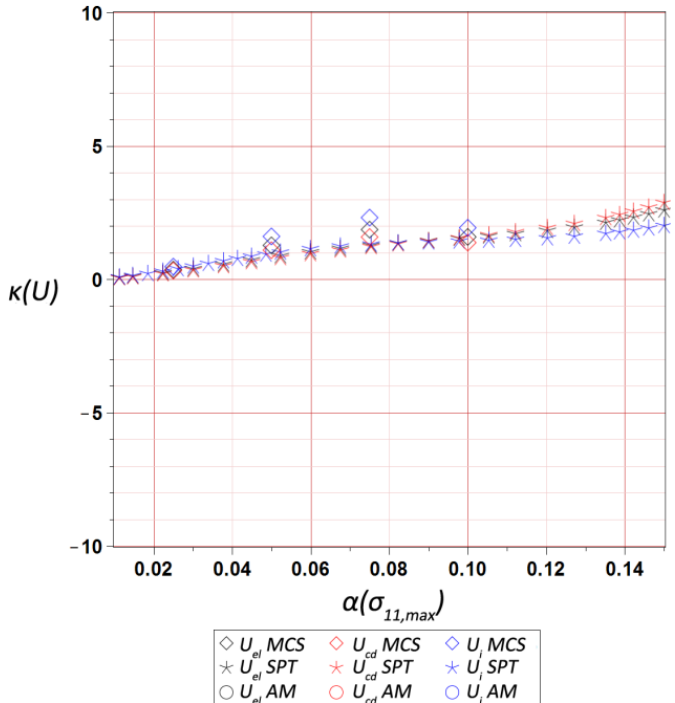
Figure 12. Kurtosis of ultimate elastic strain 𝑈 𝑒𝑙 , dissipation 𝑈 𝑐𝑑 , and internal 𝑈 𝑖 energies in the RVE vs. 𝛼(𝜎 11,𝑚𝑎𝑥 ) .